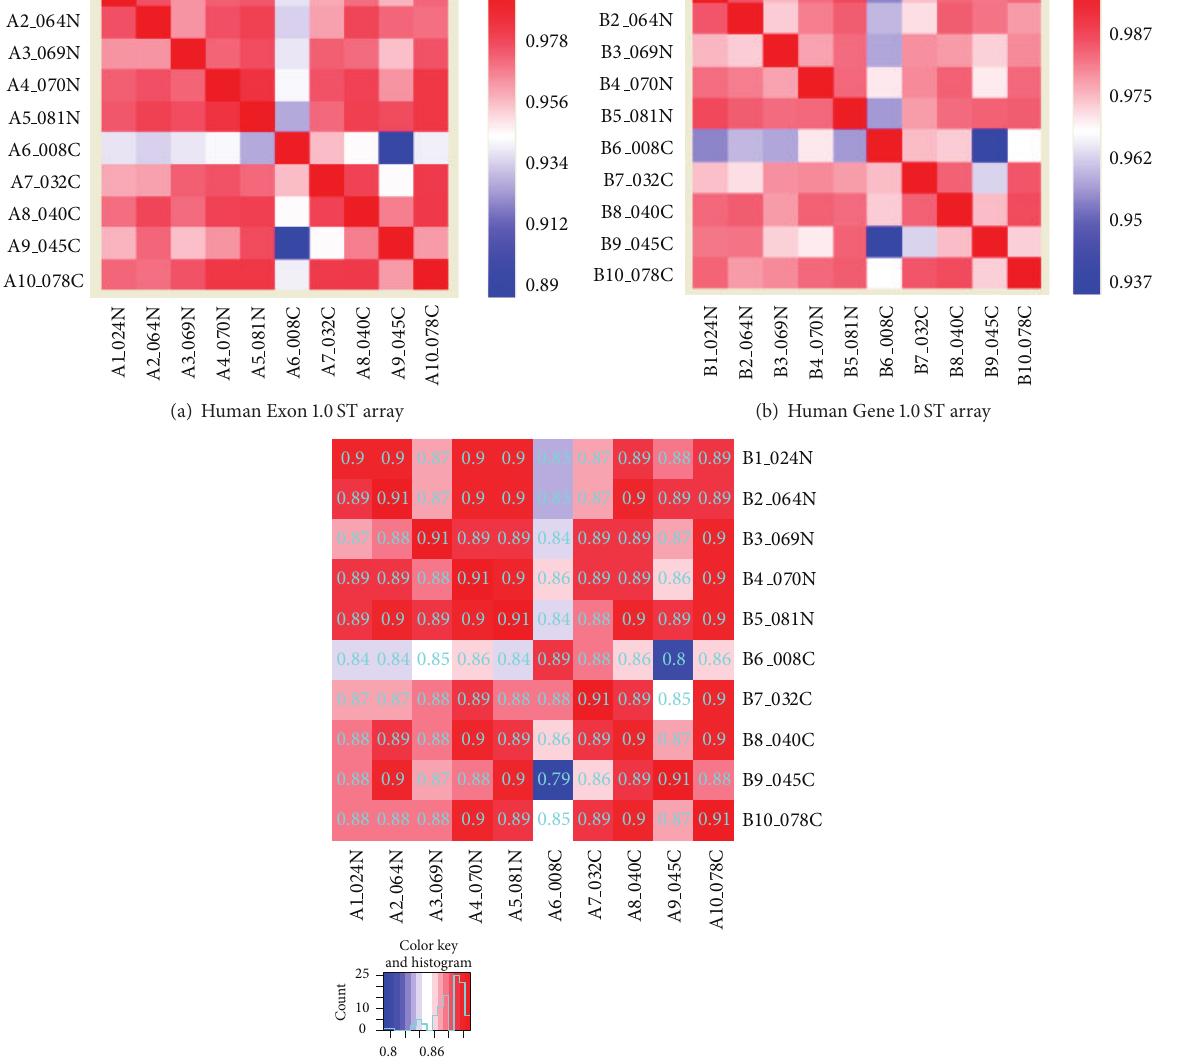
(c) A cross-platform comparison of samples. For each paired samples(fromtheExonarrayandtheGeneSTarray,resp.),the sample correlation was calculated using Pearson’s Correlation for 16,482 genes found on two platforms. The number in each box represents the correlation coefficient. The Exon array data is on x -axis, and Gene ST array data is on y -axis Figure 2: Sample correlation using RMA-normalized gene-level signals. (a) Within the Human Exon 1.0ST array; (b) within the Human Gene 1.0ST;(c) cross-platform sample correlation of the Exon and Gene ST arrays for 16,482 matched genes.